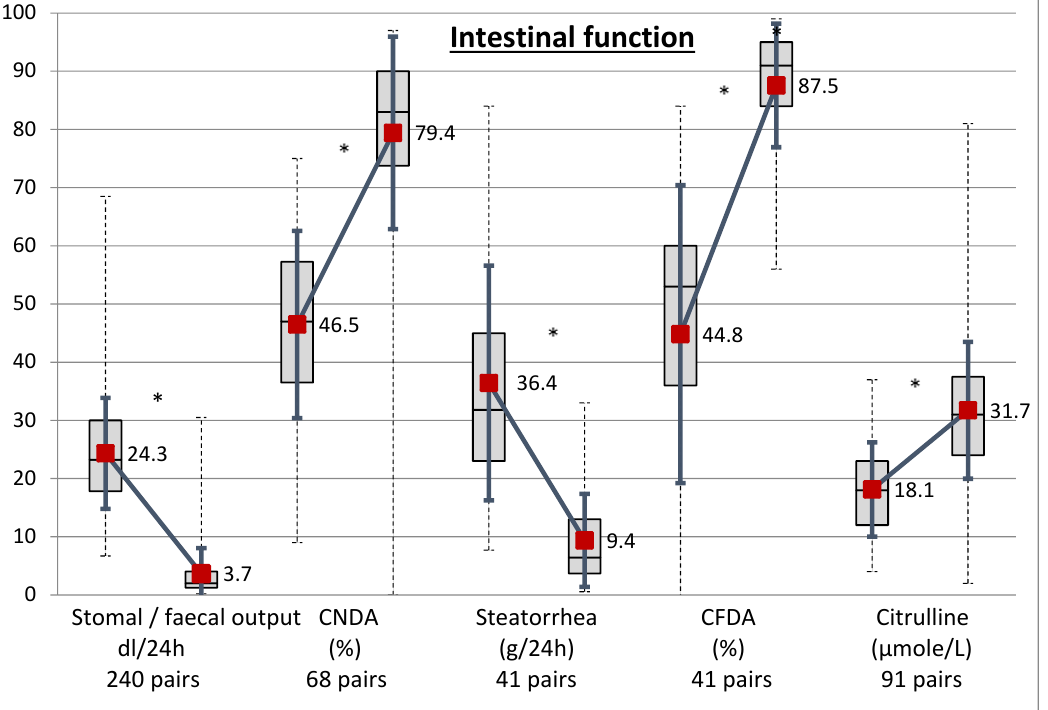
Figure 3. Comparison of intestinal function before (left boxes) and during (right boxes) chyme reinfusion. CNDA, coefficients of nitrogen digestive absorption; CFDA, coefficient of fat digestive absorption. * p < 0.000001.